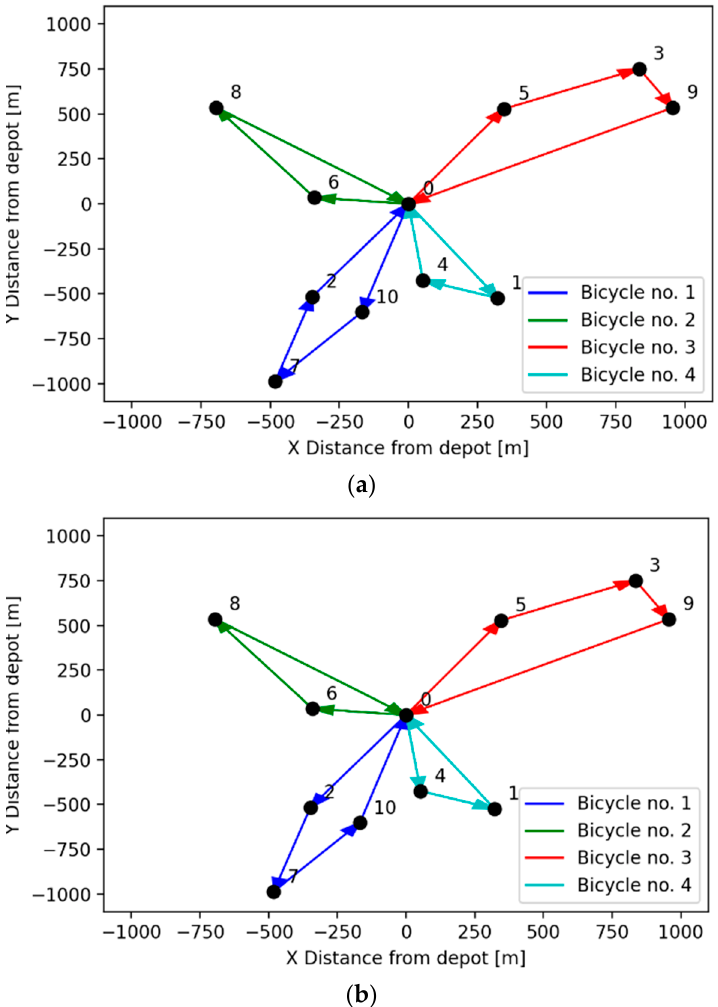
Figure 7. Histograms for all 3D feasible CVRP routes according to time ( a ) and distance ( b ). As can be seen on Figure 8 the bicycle routes with best total travel time had the same nodes as the route with minimum total travel distance, but the sequence of node visits was different.